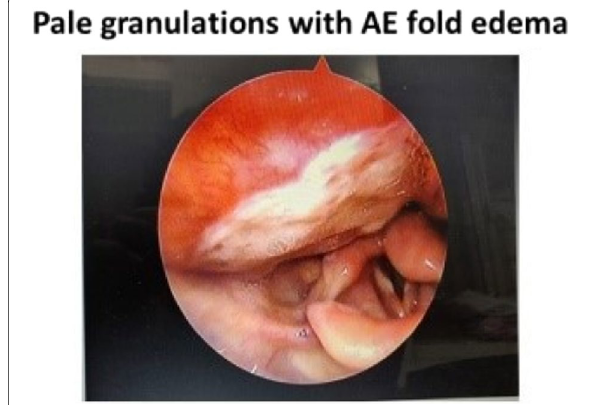
Fig. 4 Laryngeal